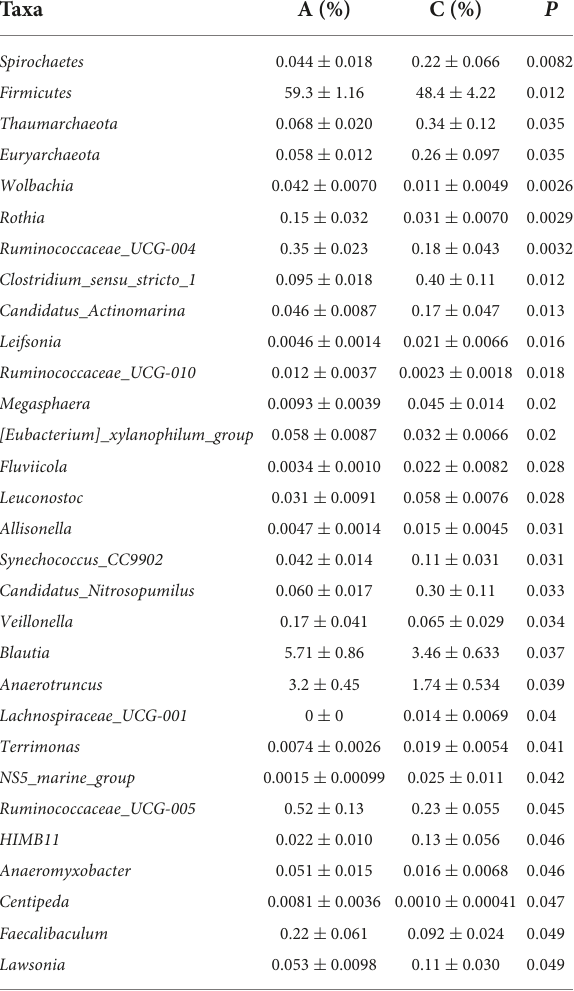
TABLE 3 Comparative analysis of differential bacteria between A and C groups.